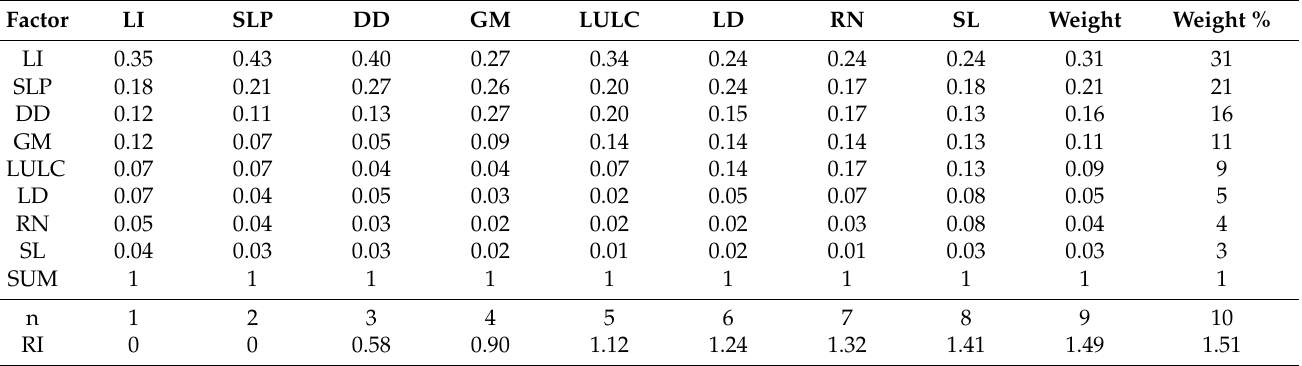
Table 5. Identifying the standardized weights for influencing factors in